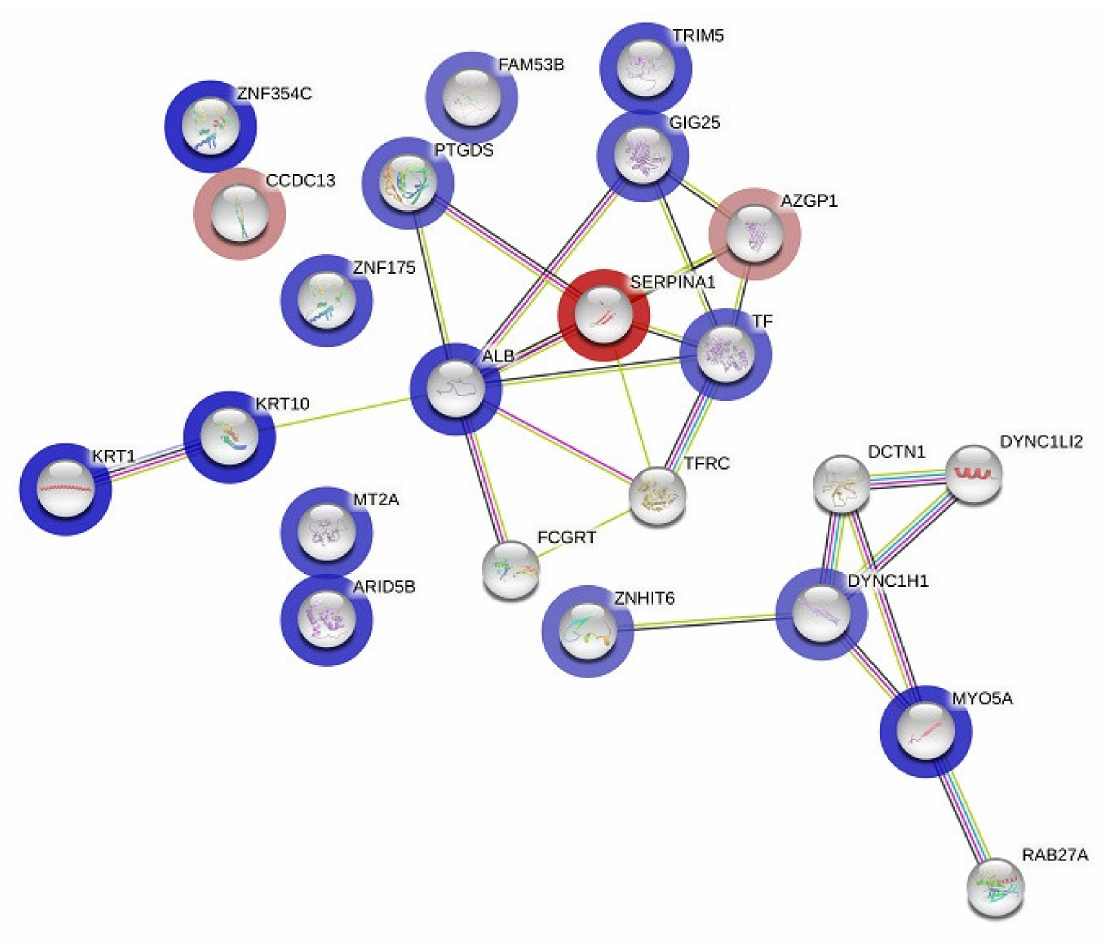
Figure 4. The differentially expressed proteins’ most enriched interaction network in both the pre- and post-treatment phases. Protein nodes with a blue or red halo denote upregulation or downregulation, respectively. Protein nodes without a halo are proposed by the STRING database and indicate potential targets that were functionally coordinated with the differentially expressed proteins. The solid black line displays co-expression; the green line indicates the gene neighborhood; the dark- blue line indicates gene co-occurrence; the purple line shows experimentally determined protein interactions. Interaction network of differentially expressed proteins in the pretreatment group compared to the post-treatment